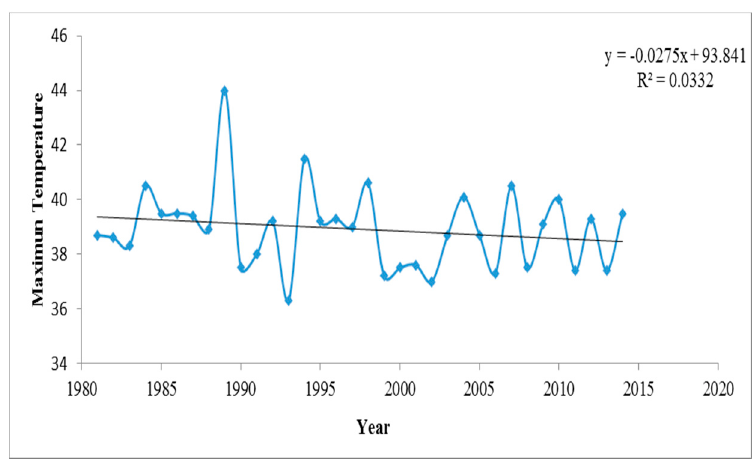
Figure 6. Trend of annual mean temperature (0 °C) of Bogra station (1981–2015).